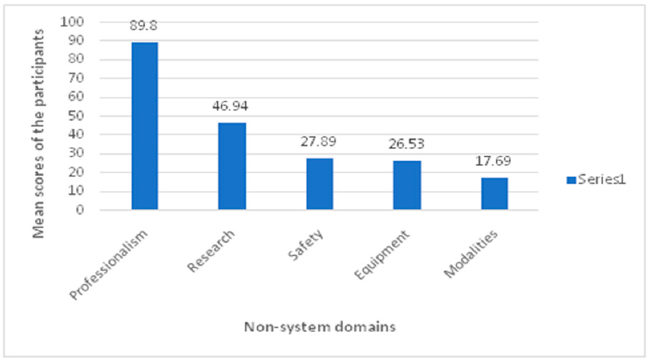
Figure 2. Mean knowledge score of participants in different non-system domains.